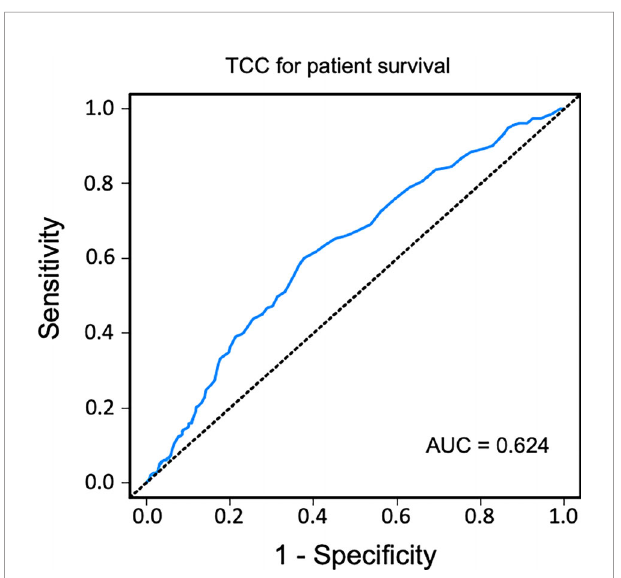
FIGURE 8 | Receiver operating characteristic (ROC) curve analysis of plasma terminal C5b-9 complement complex (TCC) concentration, 10 weeks after transplantation, as a biomarker of death-censored graft